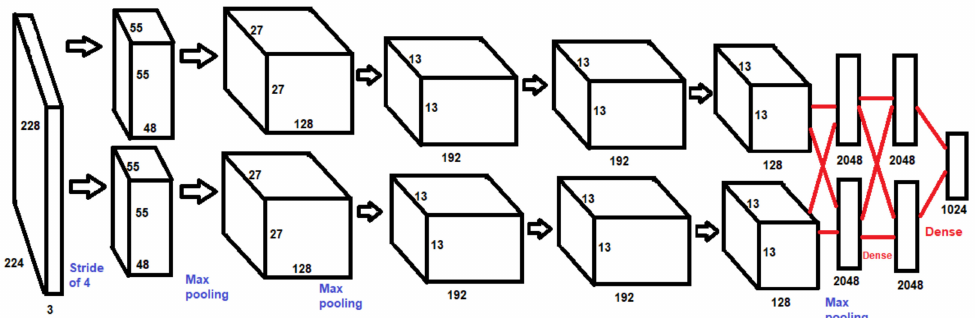
Figure 3. AlexNet architecture recreation, based on the original image found in [27].